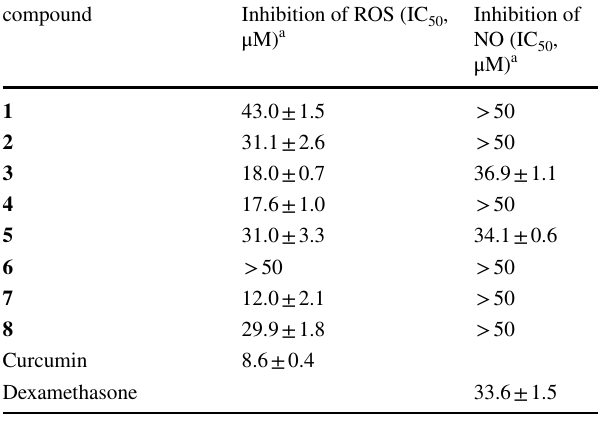
a Data are presented as mean ± SD ( n